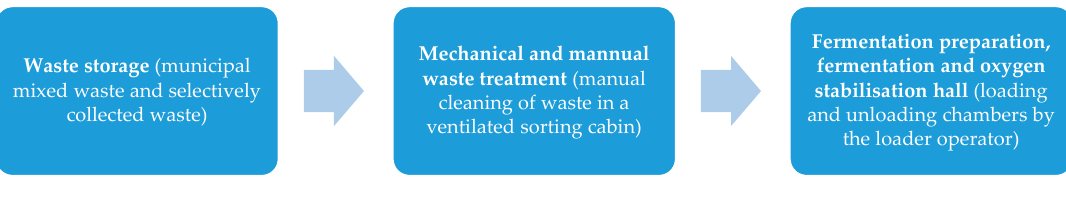
Figure 1. The technological scheme of analyzed waste treatment